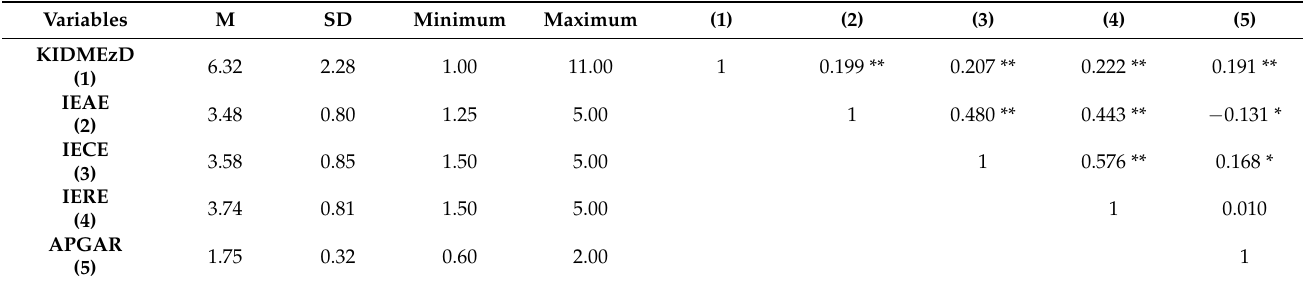
Table 2. Descriptive means outcomes of the correlational analysis of study variables.